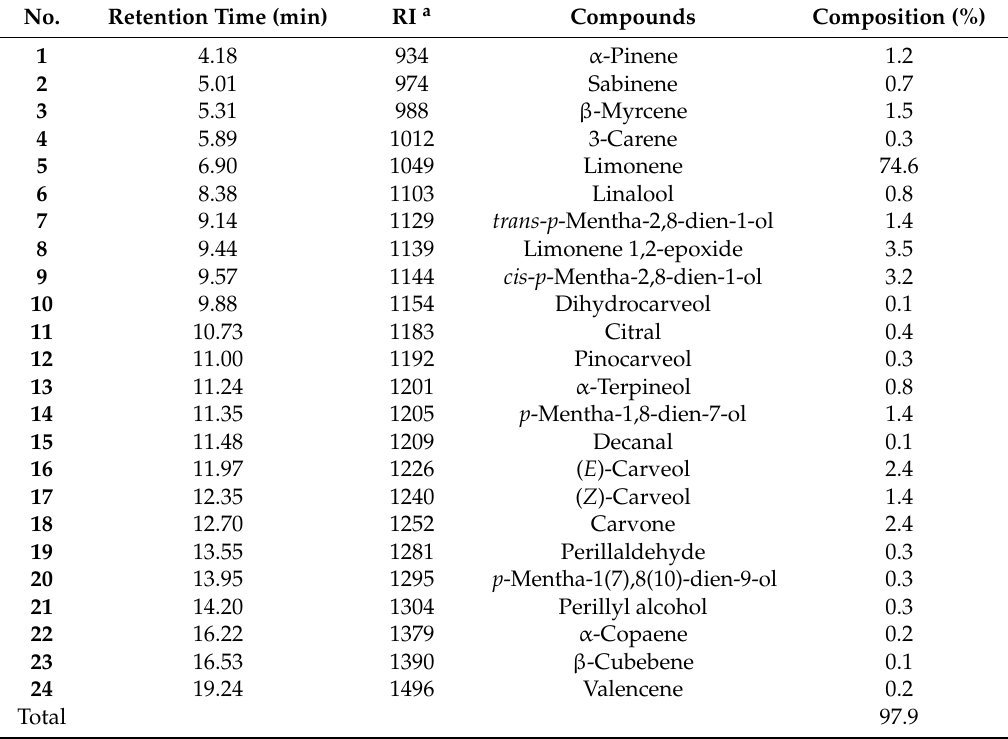
Table 1. Chemical composition of navel orange essential oil